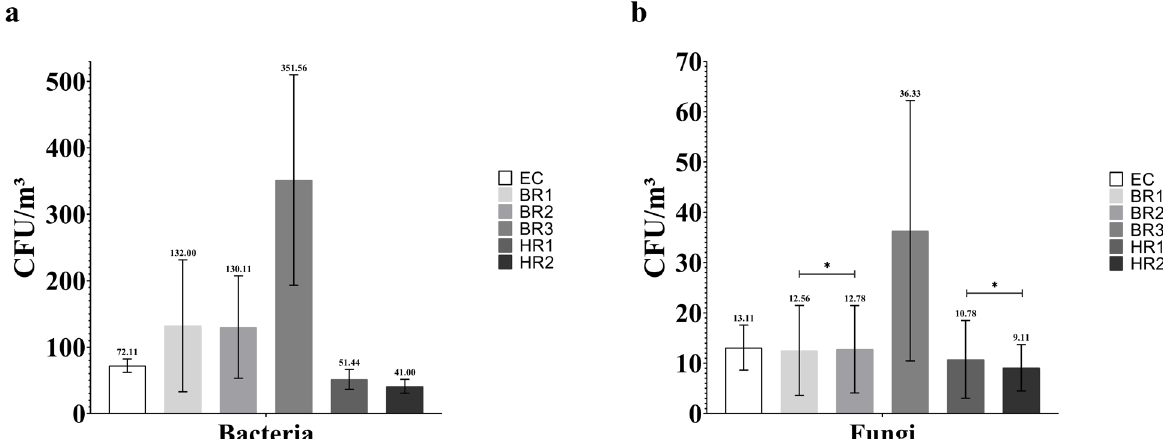
Figure 3. (a) Data presented as mean of colony forming units (CFU) per cubic meter of airborne bacteria found in the rodent facility. ( b) Data presented as mean of CFU per cubic meter of airborne fungi found in the rodent facility. EC, external control; BR1, breeding room 1; BR2, breeding room 2. BR3, breeding room 3; HR1, housing room 1; HR2, housing room 2. *Indoor/external ratio (I/E) = ≤ 1.5